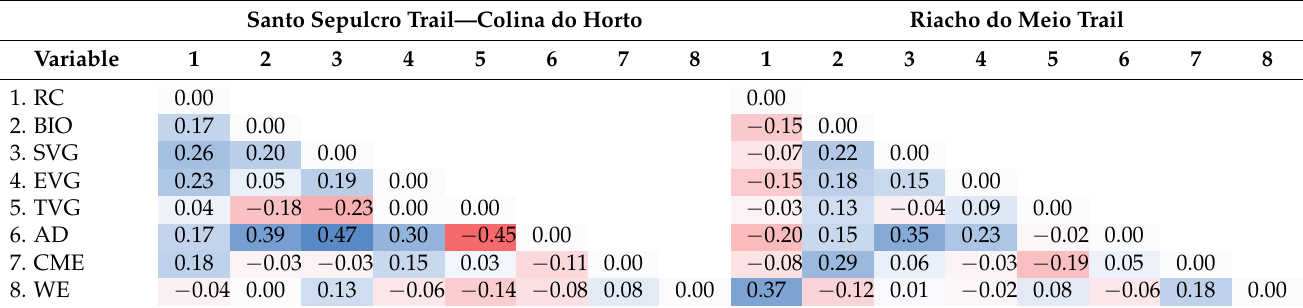
Table 8. Association matrix of network analysis Ecosystem’s Health Provision; Araripe